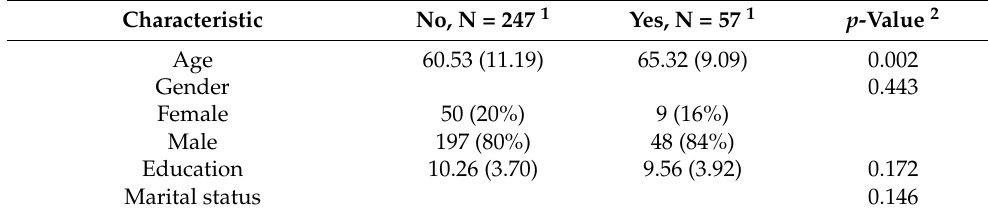
Table 3. Comparing groups with and without MACE at 24-month follow-up. 1 Mean (SD); n (%). 2 Wilcoxon rank-sum test; Pearson’s chi-squared test; Fisher’s exact test. HADS: Hospital Anxiety and Depression Scale; PRIME-MD: Primary Care Evaluation of Mental Disorder; PHQ: Patient Health Questionnaire; TCI: Temperament and Character Inventory; DS-14: Type-D Personality Scale; TAS-20: Toronto Alexithymia Scale, 20-item; DSQ-40: Defense Style